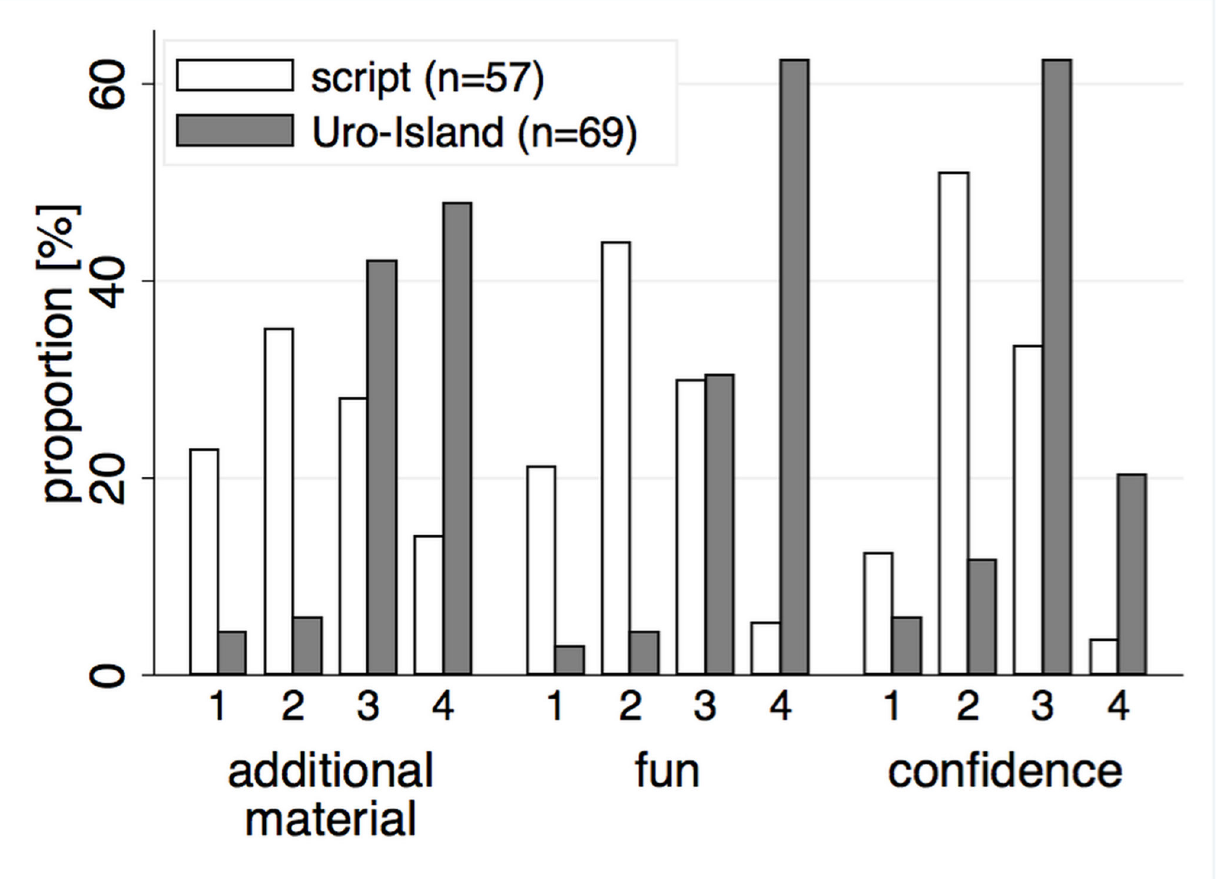
Figure 5. Students' attitudes towards the learning experience, answers on the questionnaire on a 4-point Likert scale